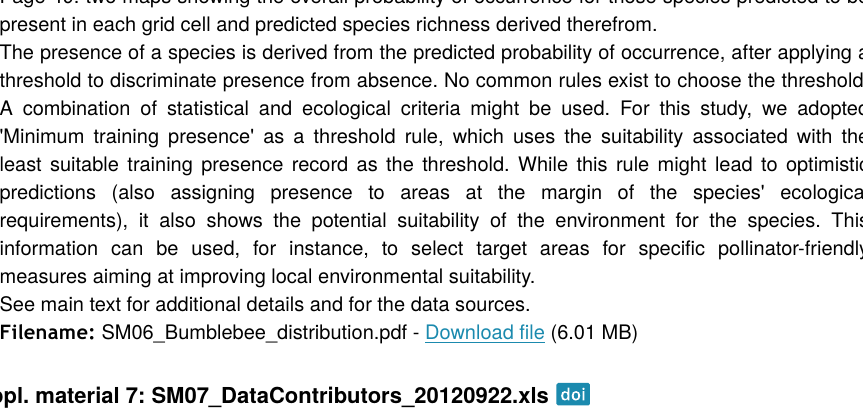
Page 49: two maps showing the overall probability of occurrence for those species predicted to be present in each grid cell and predicted species richness derived